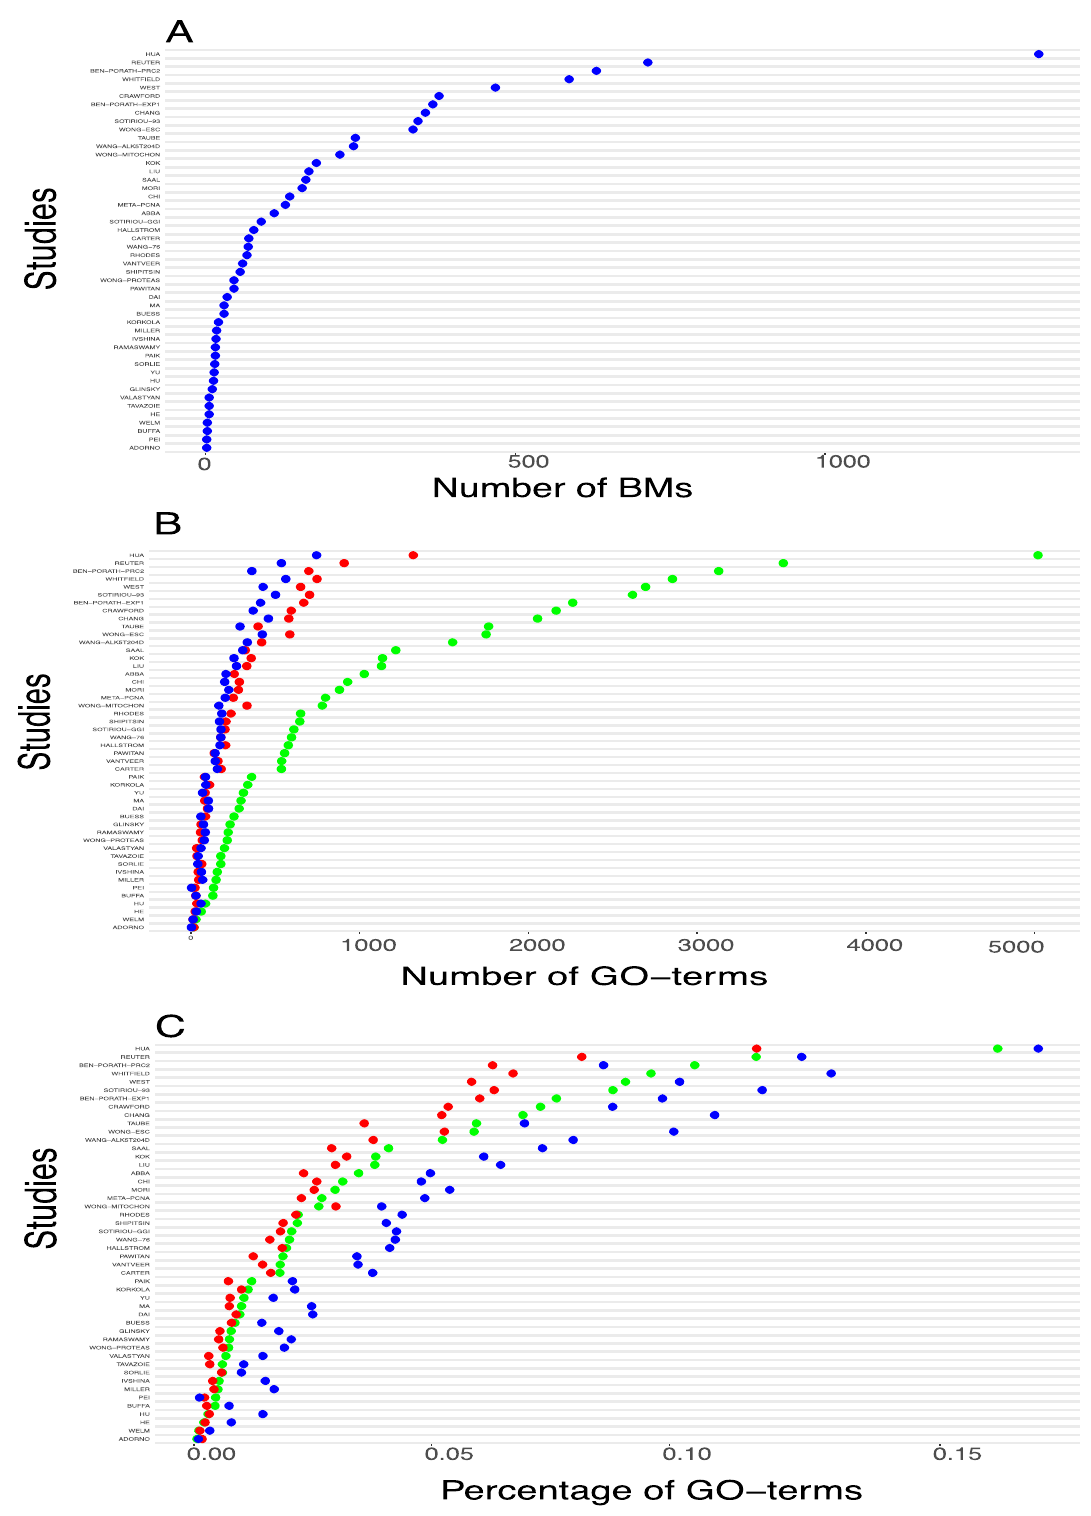
Figure 2. ( A ) Overview of the total number of biomarker genes in each study. ( B ) Shown is the number of GO-terms in each study. The green points correspond to BP, the red points to MF and blue points to CC. ( C ) The percentage of GO-terms of BP, MF and CC used by each study. The color is the same as for